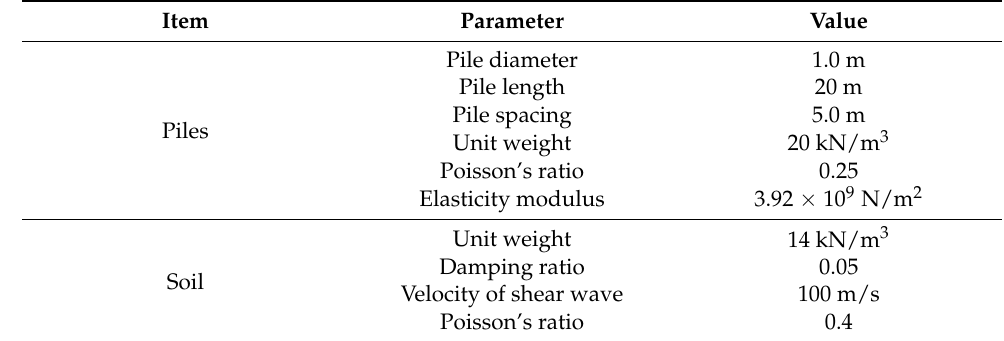
Table 1. Parameters of the 4 × 4 pile-group